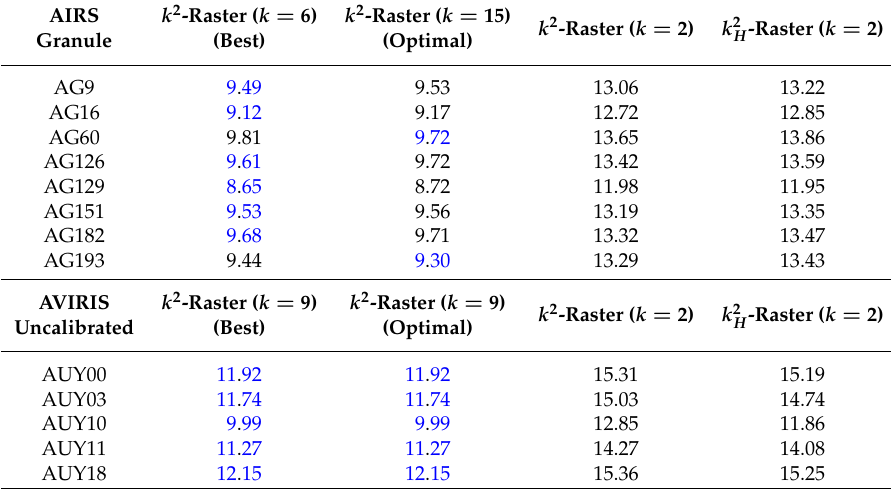
Table 11. Comparison of the structure size (bpppb) built from k 2 -raster and k 2 The sizes for k 2 -raster using the best k value and the optimal k value are also shown. The best results are highlighted in